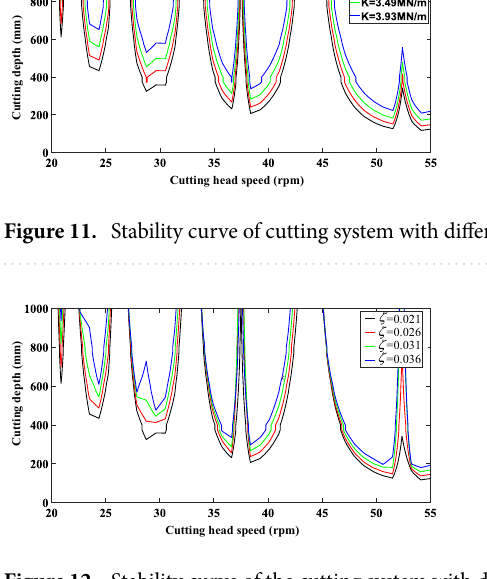
Figure 12. Stability curve of the cutting system with different damping